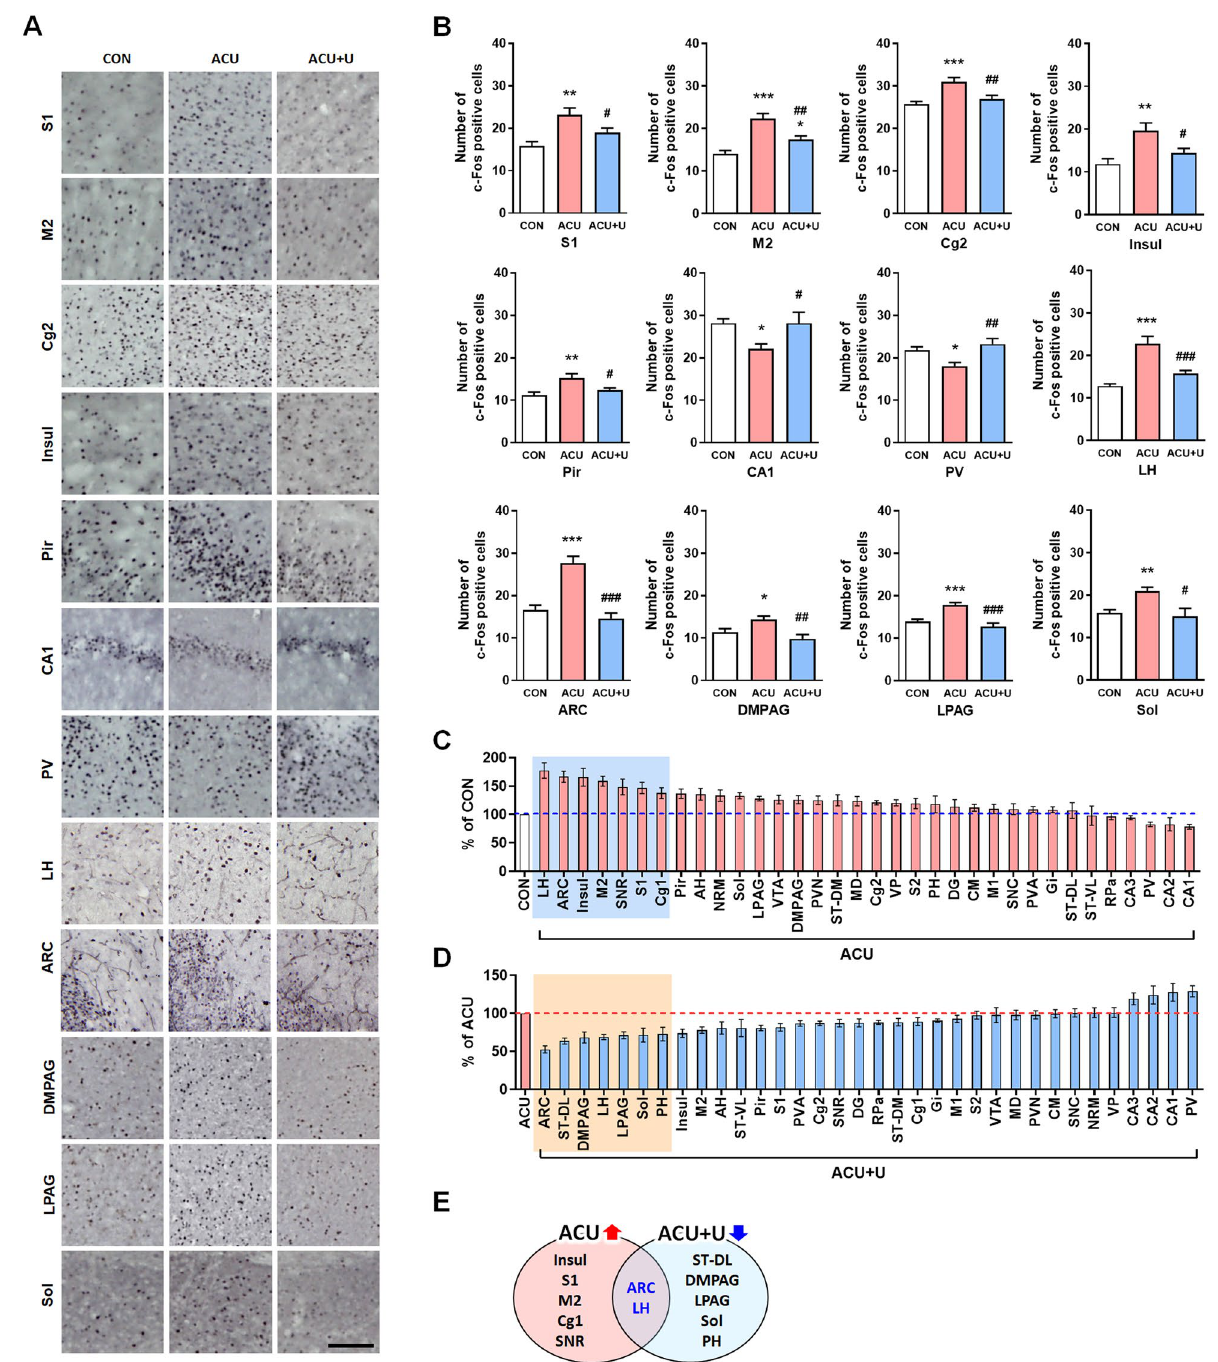
Figure 3. Expression of c-Fos after acupuncture treatment expressed in each brain region. ( A , B ) The number of c-Fos-positive cells changed after acupuncture or acupuncture with U0126 administration. ( C ) Increased percentage of c-Fos-positive cells after acupuncture treatment compared to the control group. ( D ) Decreased percentage of c-Fos-positive cells after U0126 administration followed by acupuncture treatment compared to the acupuncture treatment only. ( E ) The overlap between brain regions ranked above the 80th percentile for acupuncture increased, and U0126 decreased-c-Fos activation. CON control, ACU acupuncture treatment, ACU + U U0126 administration followed by acupuncture treatment. Abbreviations for each brain region are shown in Table 1. * P < 0.05, ** P < 0.01, *** P < 0.001 compared to the CON group. # P < 0.05, ## P < 0.01, ### P < 0.001 compared to the ACU group. One-way ANOVA was followed by the Newman–Keuls post-hoc test. Data are expressed as the mean ± SEM. The number of animals in each group is shown in Table